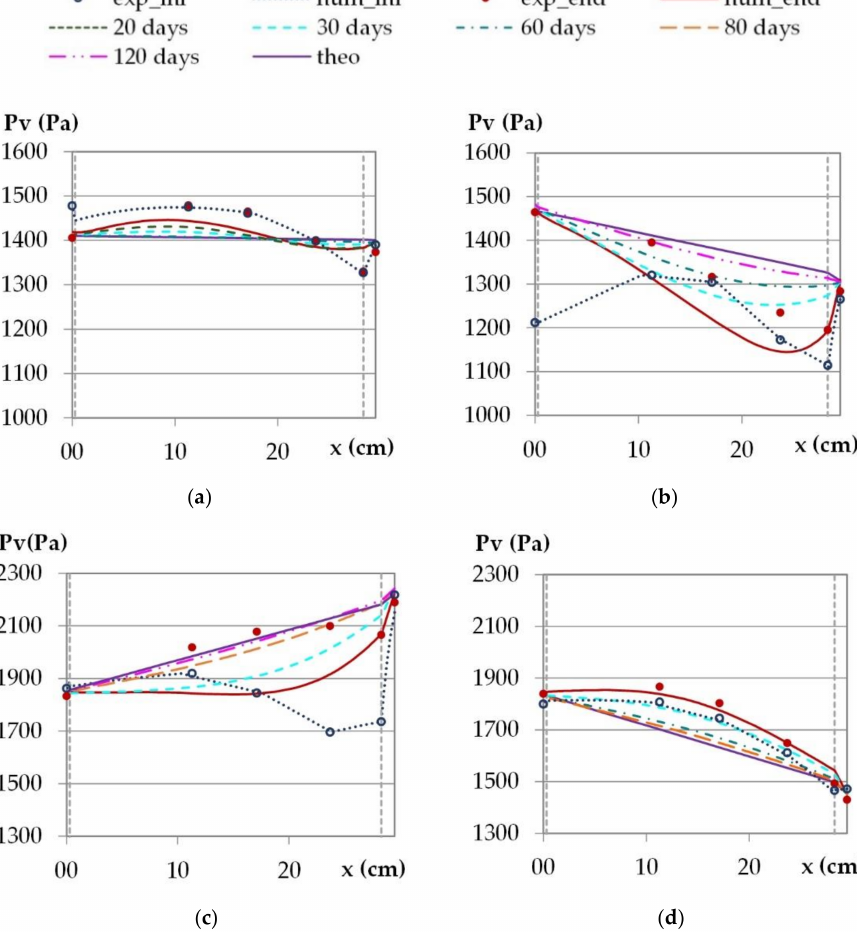
Figure 10. Vapor pressure profiles under constant temperature and vapor pressure gradients, the- oretical, experimental and numerical average values over the last 24 h of the stabilization phase: ( a ) climate of Toulouse, ( b ) climate of Rennes, ( c ) climate of Djerba, ( d ) climate of